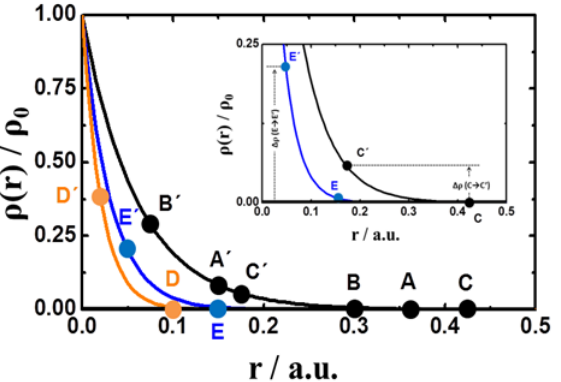
Figure 5. Plots of the density distribution corresponding to the set of particles used in experiments as a function of the particle radius. Capital letters without commas refer to the original particles, whereas commas on capital letters indicate the same particles after plasma application. This inset illustrates the difference in polymer density, Δρ , for particles C and E before and after plasma application.